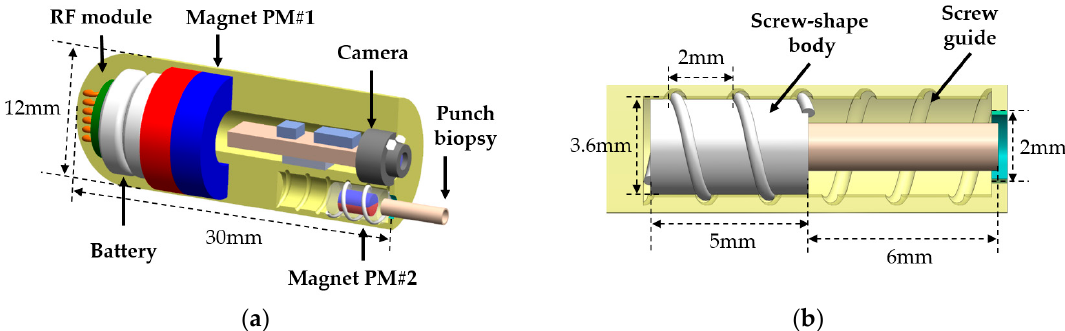
Figure 2. ( a ) Conceptual design of the proposed biopsy CE. ( b ) Design details of the novel punch biopsy module.